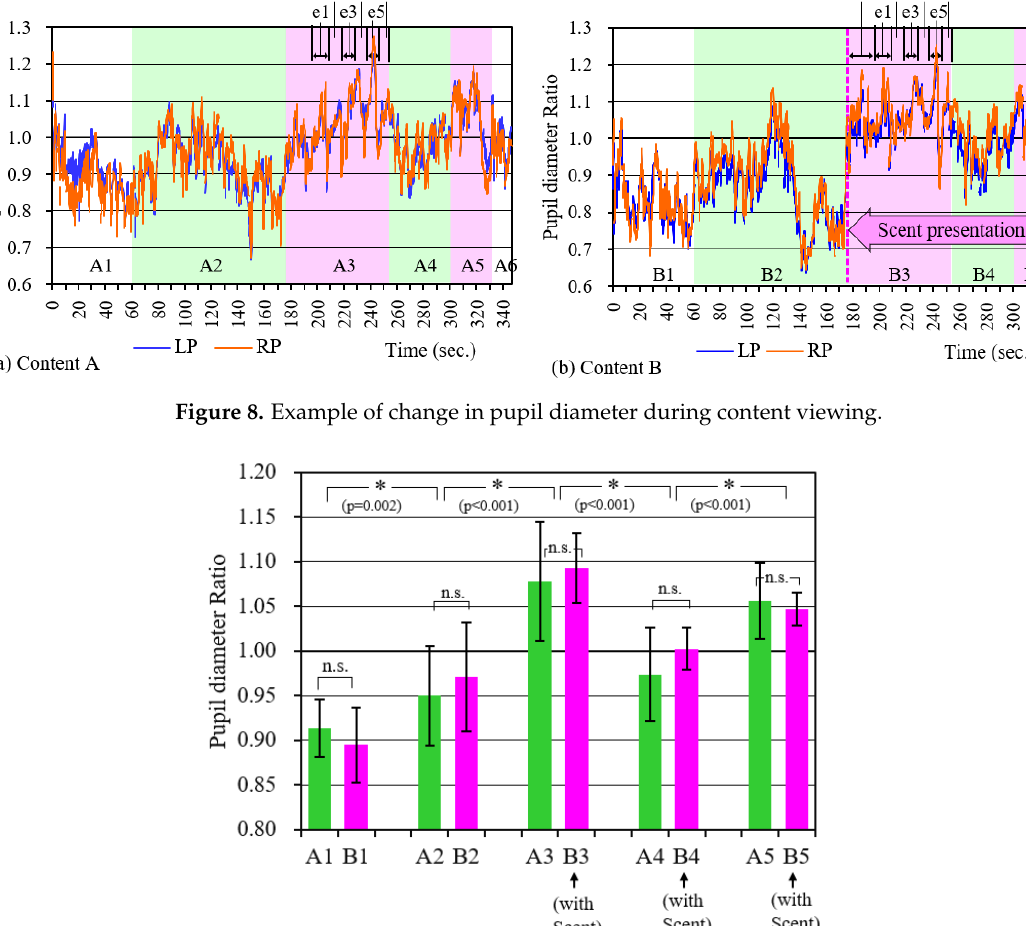
Figure 7. Gaze-point measurement results.